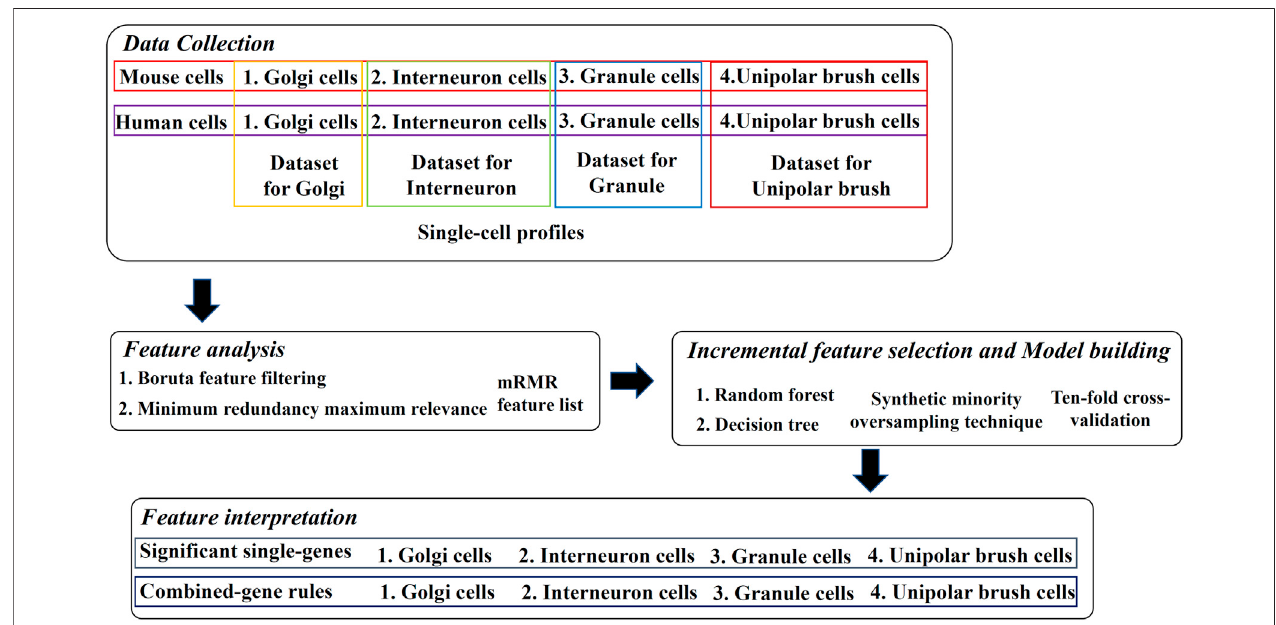
FIGURE 1 | Overview of the design. Four types of mouse and human cerebellum cells constitute four datasets, where cells are represented by single-cell pro fi les. The pro fi les are analyzed by Boruta and minimum redundancy maximum relevance feature selection methods one by one, resulting in one mRMR feature list on each dataset. The list is used in the incremental feature selection, incorporating some classi fi cation algorithms, synthetic minority oversampling technique and ten-fold cross- validation to extract signi fi cant single-genes and combined-gene rules.